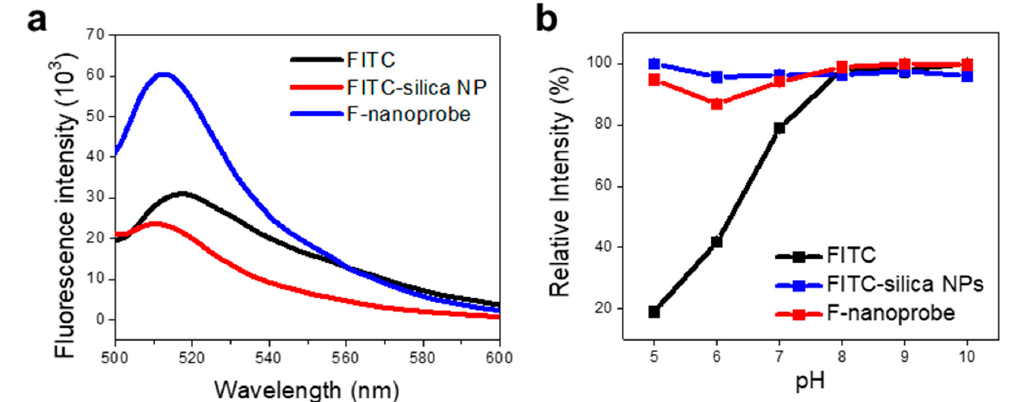
Figure 3. ( a ) Fluorescence spectra of FITC (black), F-nanoprobe (blue) and FITC-silica NPs prepared without PLGA (red). ( b ) Plots of relative fluorescence intensity versus pH for FITC (black), F-nanoprobe (blue), and FITC-silica NPs without PLGA (red). Table 1. Oligonucleotide sequences used in the experiments